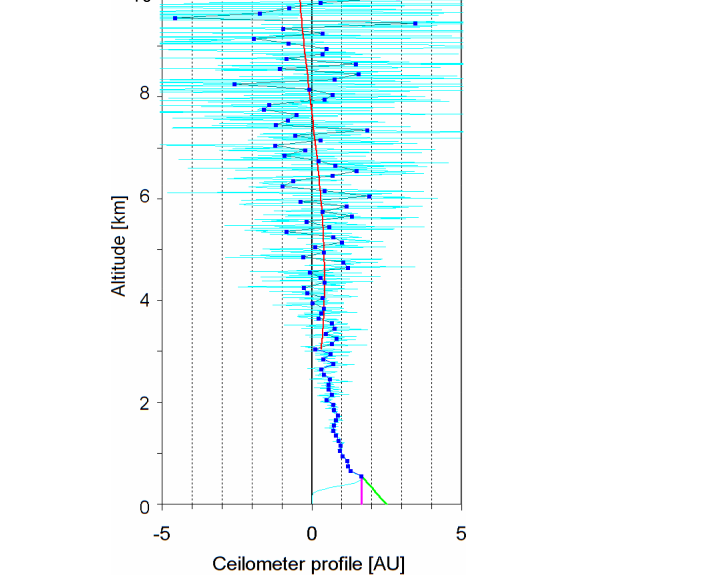
Figure A9. The light blue data show the original backscatter profile averaged between 14:00 and 15:00UTC. The blue dots show the smoothed (with a 100m kernel) profile, which are used between 500m and 3km. Below 500m, either constant or linearly extrapolated data (see text) are used. Between 3 and 10km, a third-order polynomial is fitted to the raw data. The polynomial values are used between 3km and the altitude at which they become negative. Above, the values are set to